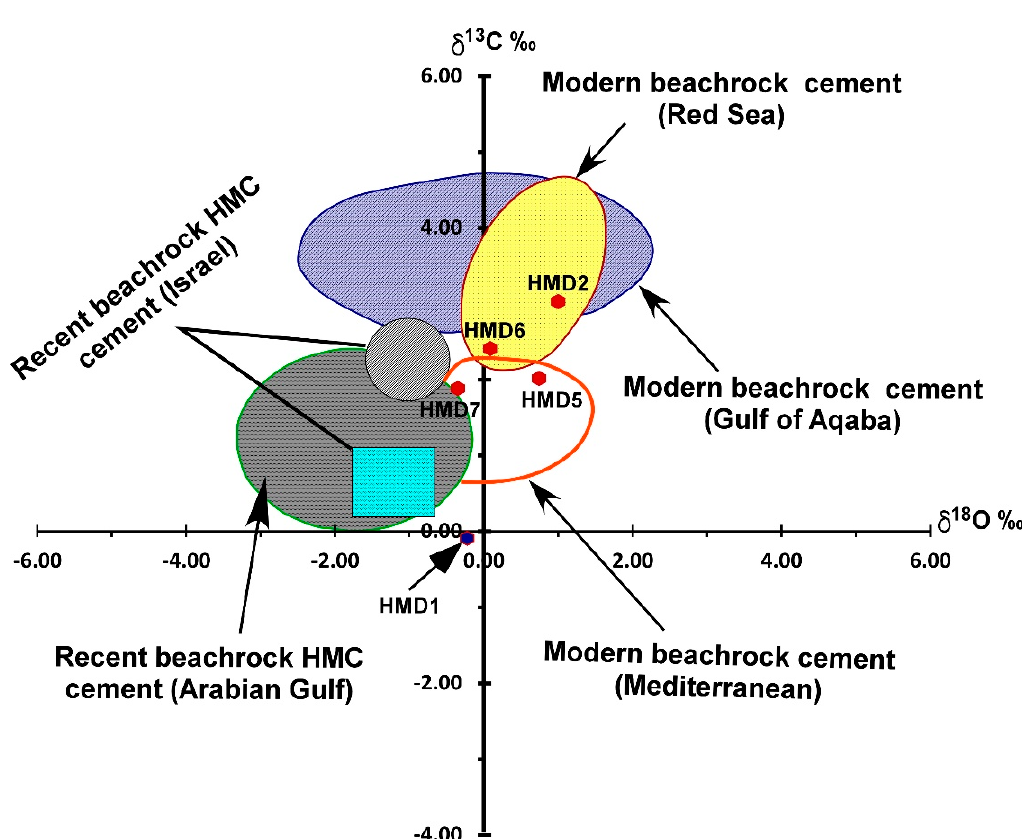
Figure 6. Bivariate plot between carbon and oxygen stable isotope composition of the Wadi Al-Hamd beachrocks and other beachrocks in the Arabian and Aqaba gulfs [32], Bahamian beachrocks [43], Red Sea and Mediterranean Sea [19], Mediterranean beachrocks of Israel